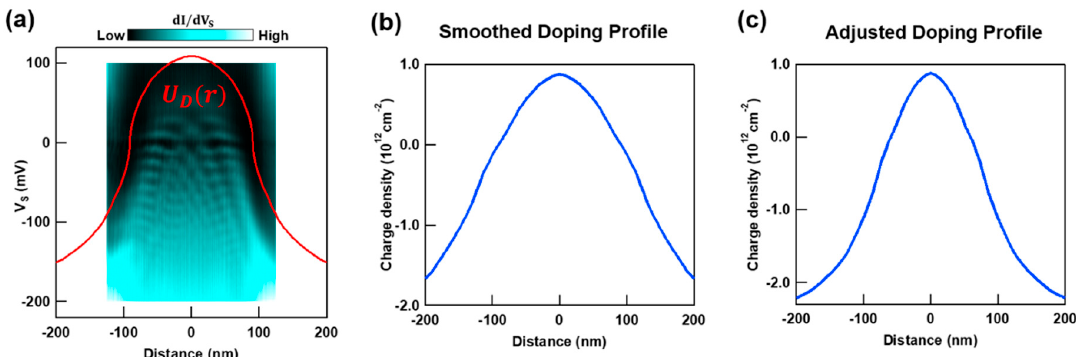
Figure 3. Charge density profile induced on graphene by charged hBN defects. ( a ) Experimentally approximated QD potential profile. The underlying two-dimensional (2D) plot shows the spatial dependence of QD states (similar to Figure 2c–e). The red line (same as U D ( r ) in Figure 1b) represents the extracted potential profile for the graphene QD. ( b ) QD’s charge density profile converted and smoothed from the extracted potential profile in ( a ). ( c ) QD’s charge density profile used in our tight-binding (TB) calculation after adjustment. This profile’s x -axis is 65% of the profile in ( b ).